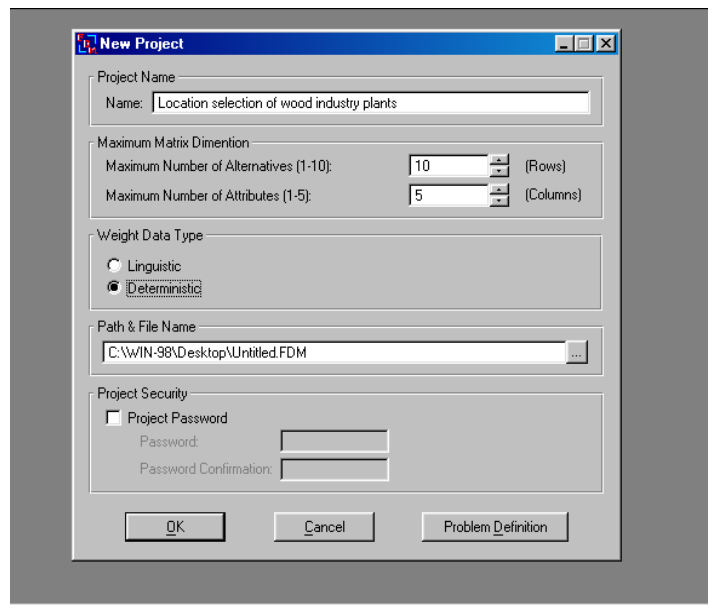
Figure 2: Description of the problem in